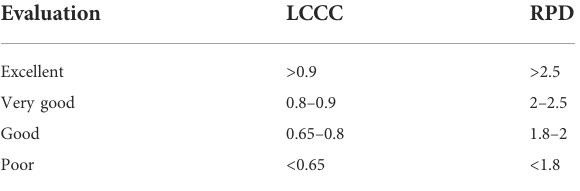
TABLE 3 Result of similarity